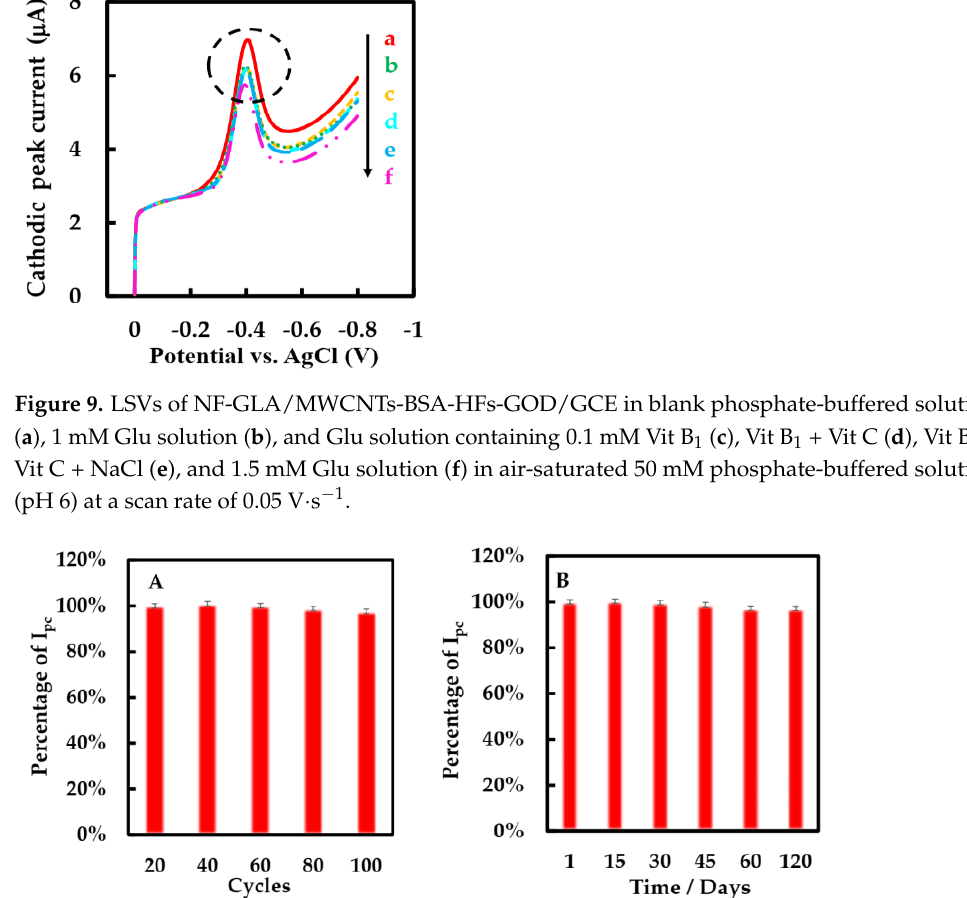
Table 4. Determination of Glu in plasma samples.